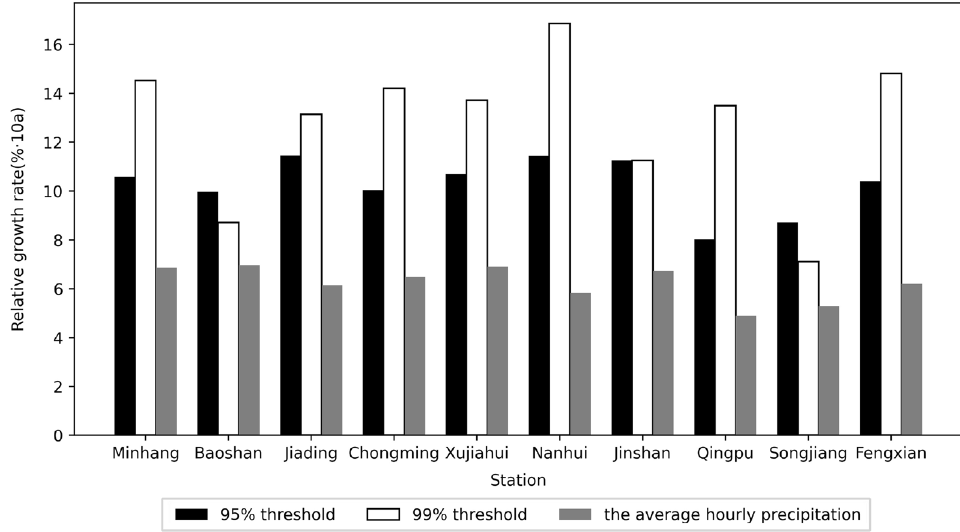
Figure 4. Relative growth rate of extreme precipitation under different threshold conditions at each station.